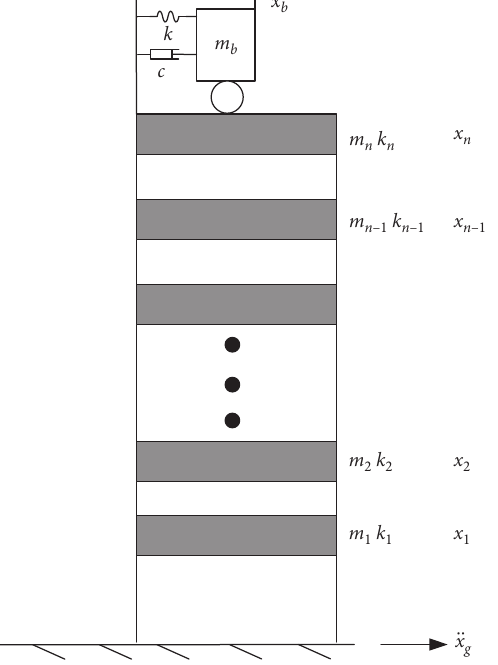
Figure 5: Schematic diagram of TMD installed in the multi-de- gree-of-freedom